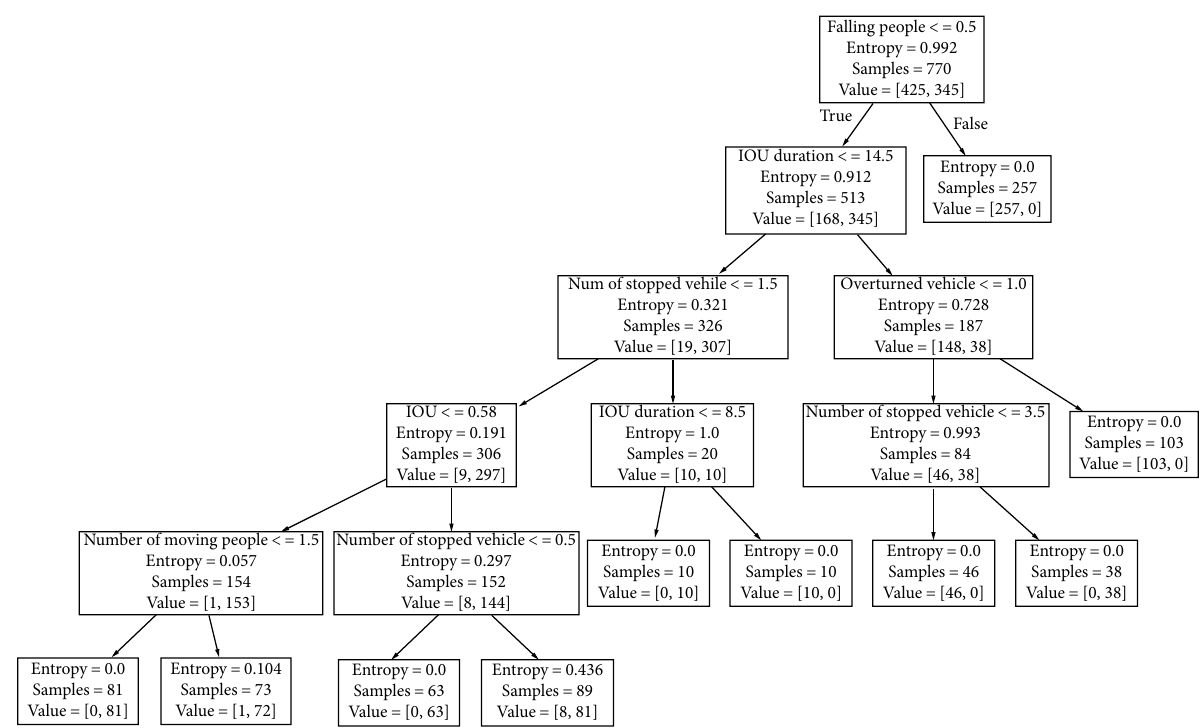
Figure 9: Trained decision tree model.